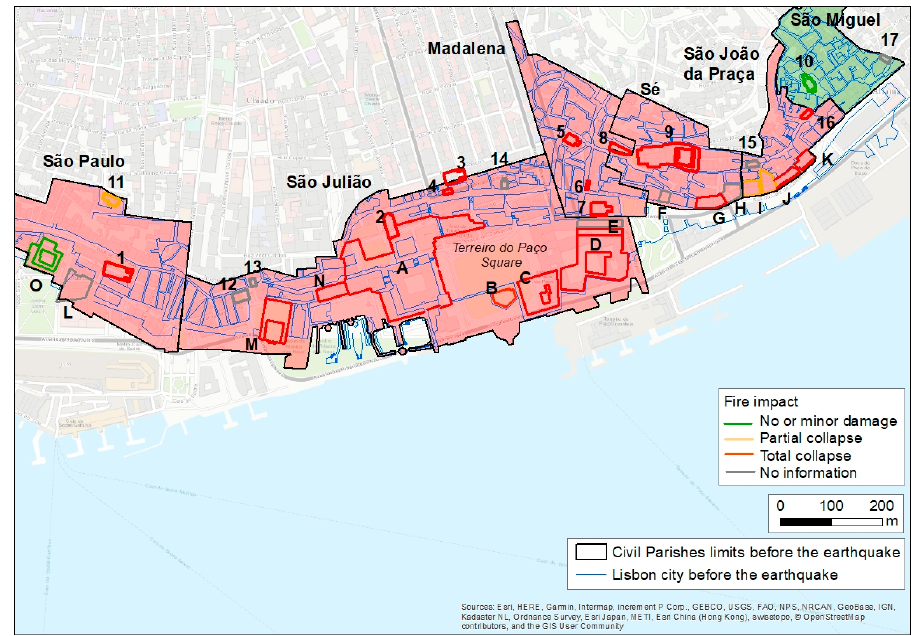
Figure 11. Damage classification caused by the fire on churches, other buildings and the overall damage on each civil parish at the study area. The list of churches and buildings is given in the caption of Figure